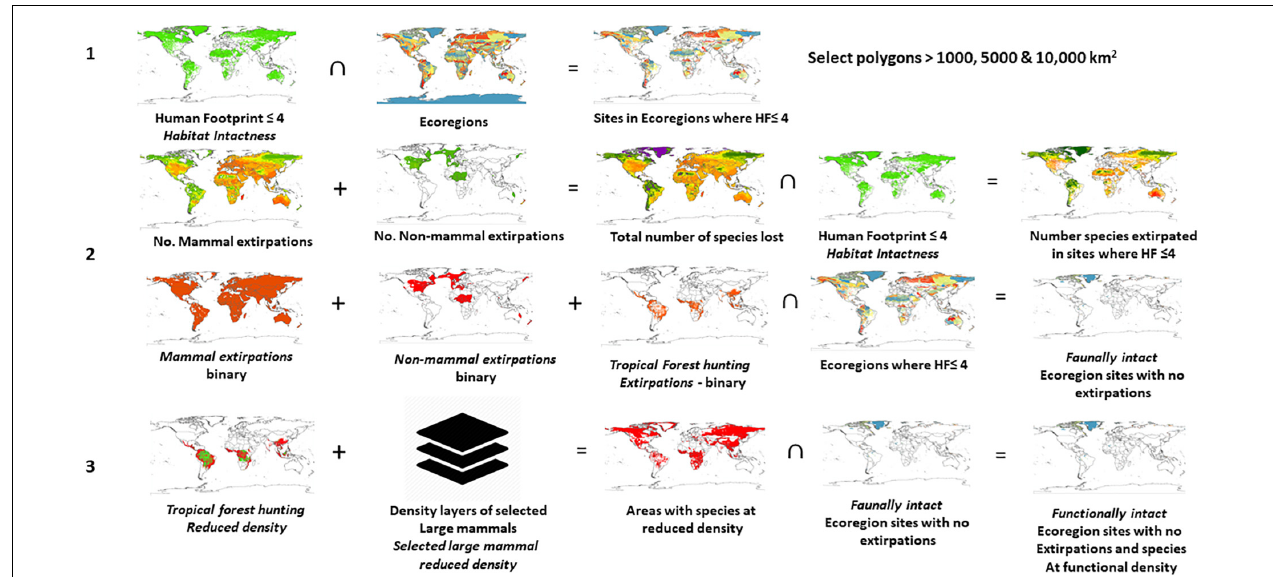
FIGURE 1 | Diagram of the analysis process to calculate habitat intactness, faunal intactness, and functional intactness. ( ∩ = intersect with).